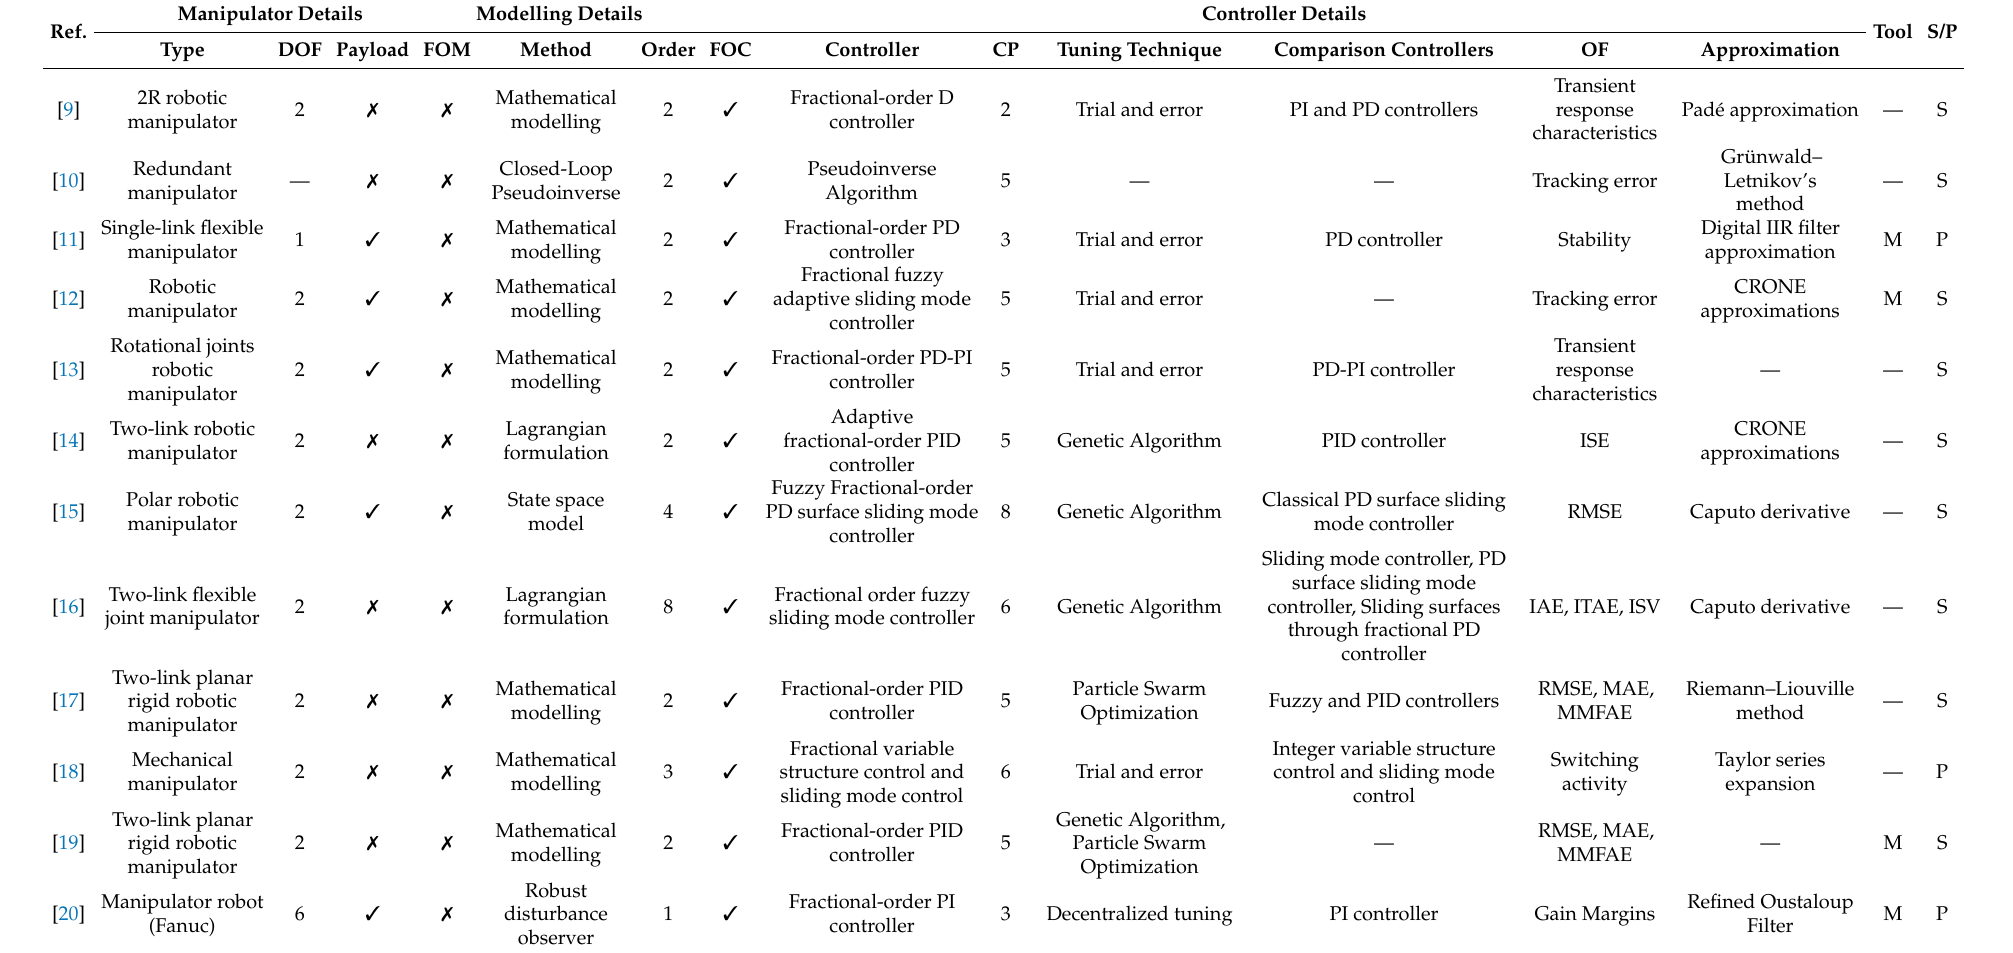
Table 1. Summary of works focussed on fractional-order modelling and controlling of robotic manipulators.